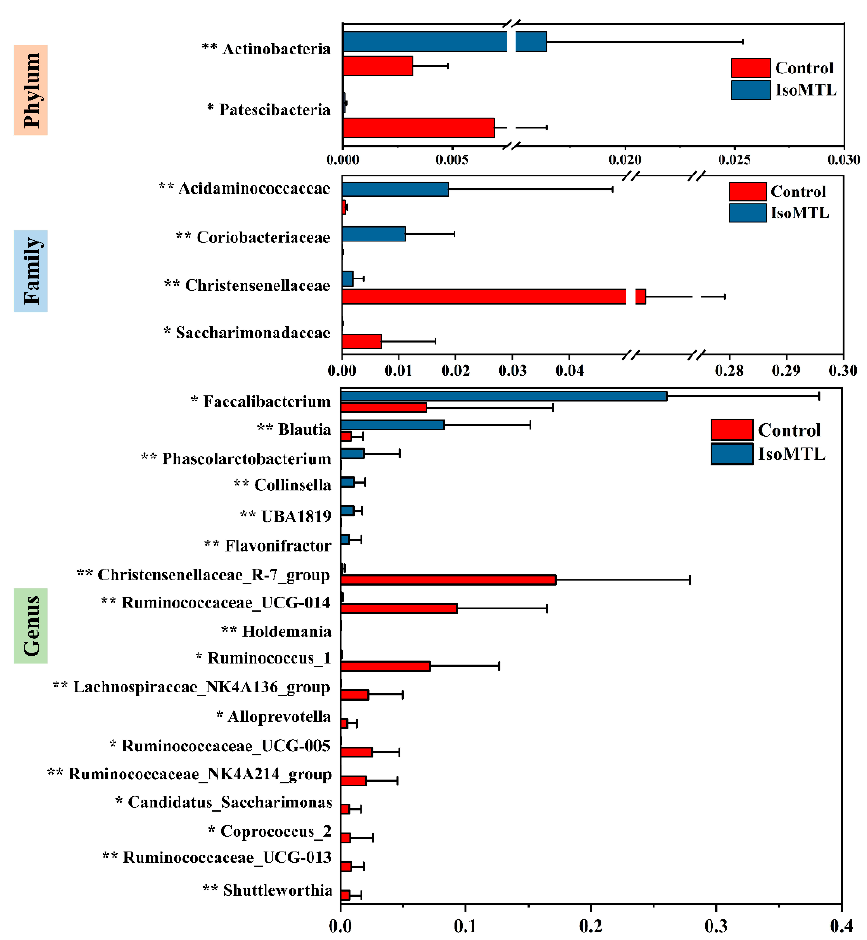
Figure 5. The significantly altered microbiota at phylum, family, and genus levels by LEfSe analysis. * represents the differences between control and IsoMTL rats (* p < 0.05, ** p < 0.01).